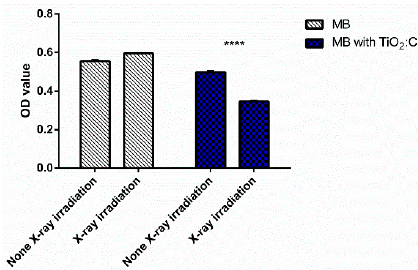
Figure 3. The generation of ROS of the synthesized TiO 2 :C under X-ray irradiation determined by the degradation of methylene blue. The measurement was performed at a wavelength of 664 nm. The concentration of TiO 2 :C particles and MB were 1 mg / mL and 10 ppm, respectively. The exposure of X-ray irradiation is 100 s ( t -test, mean ± SD, n = 6, ****: p -value <